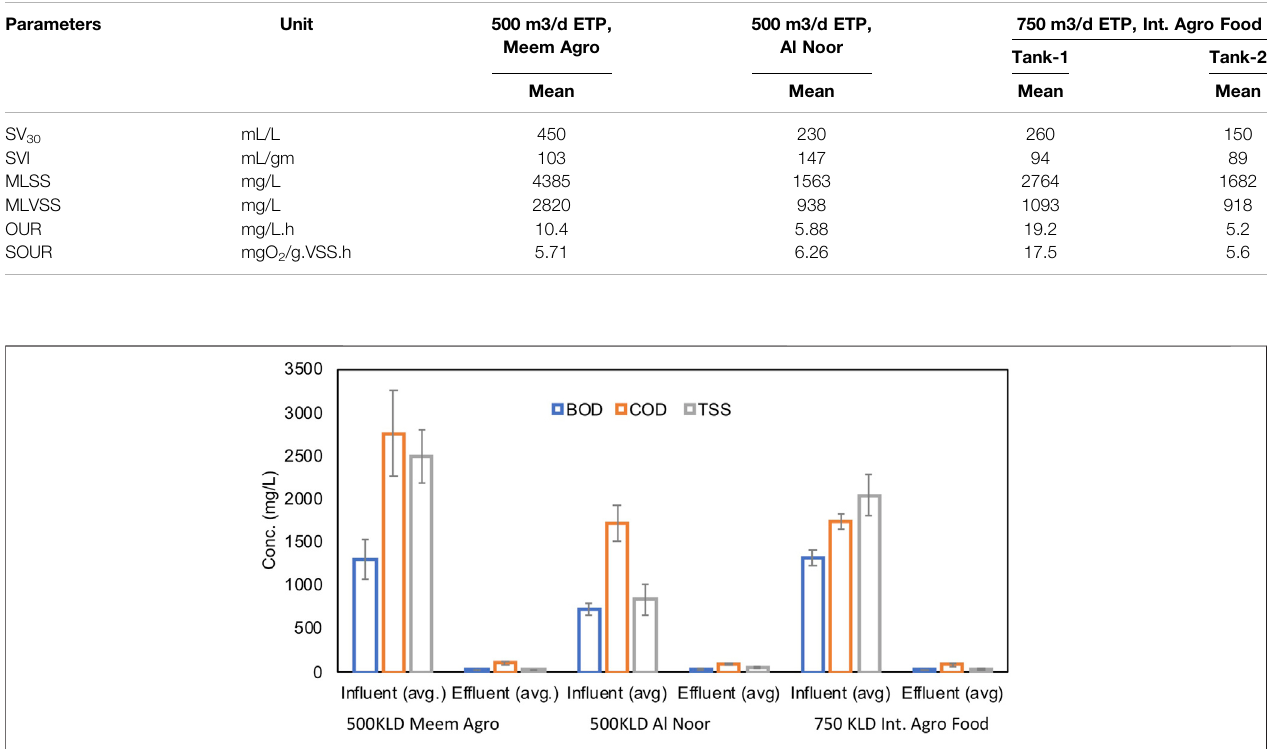
FIGURE 5 | Organic and suspended solids removal in terms of COD, BOD, and TSS in the ETPs at Meem Agro, Al Noor and IAF Pvt., Ltd.